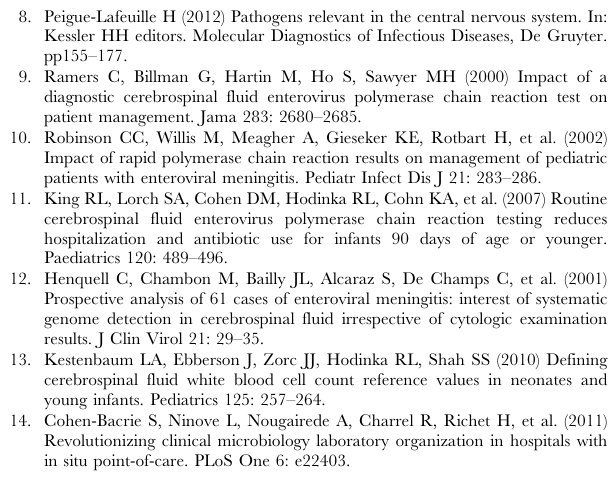
Table S1 Clinical characteristics of patients on admission over the two study periods (2005 vs